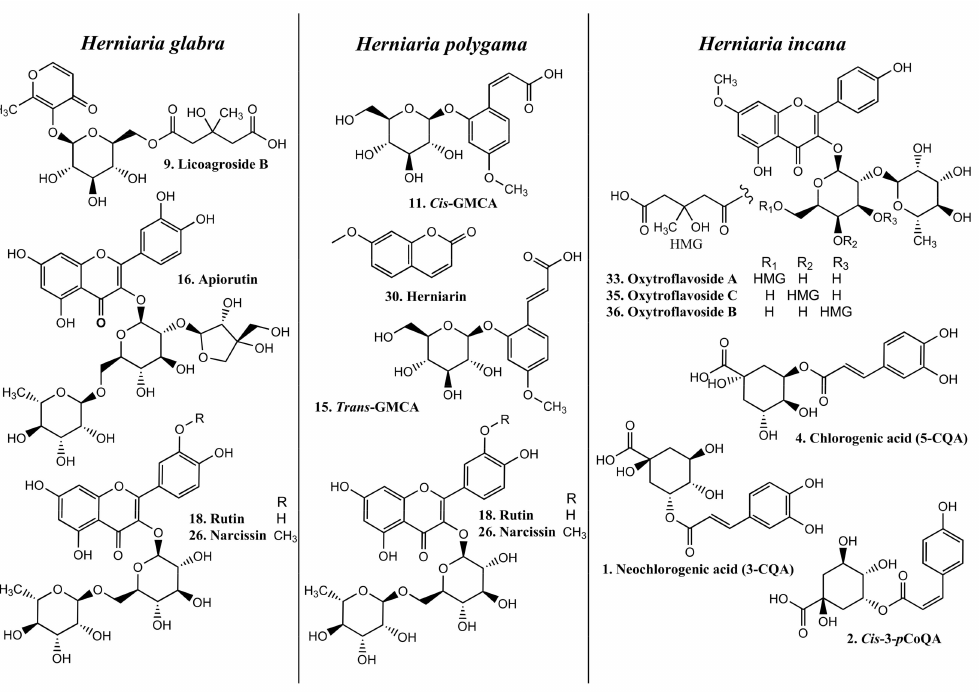
Figure 1. Chemical structures of the main phenolic metabolites in the studied Herniaria purified extracts.